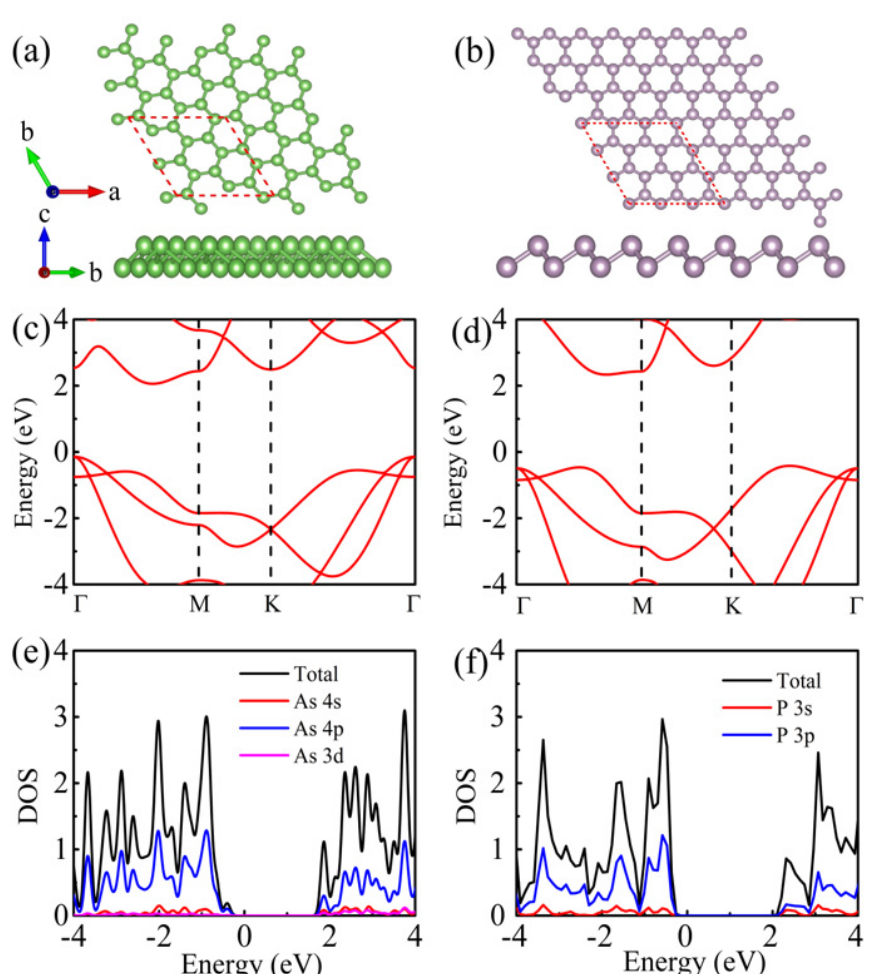
Figure 1. Schematic views of ( a ) As and ( b ) BlueP monolayers from top view and side view. The green and purple spheres represent As and P atoms, respectively. The dash curve rhombuses in ( a ) and ( b ) show a supercell and a 3 × 3 supercell, respectively. ( c , d ) The band structures of ( c ) As and ( d ) BlueP monolayers calculated based on HSE06 exchange-correlation functional. ( e , f ) Total and partial DOS of ( e ) As and ( f ) BlueP monolayers based on HSE06 exchange-correlation functional.